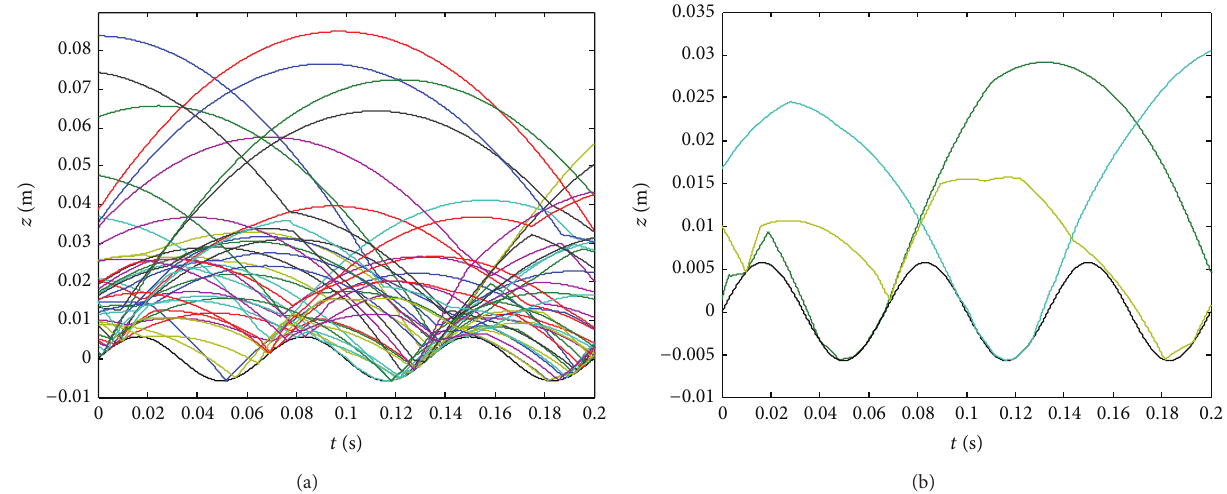
Figure 5: (a) A snapshot of locations of all grains and base at different instances of time during fluidization at 15Hz. Black solid line represents the location of base while trajectories of all particles are represented as colored lines other than black. (b) A subset of (a) with representation of trajectories of three extended type II collisions at